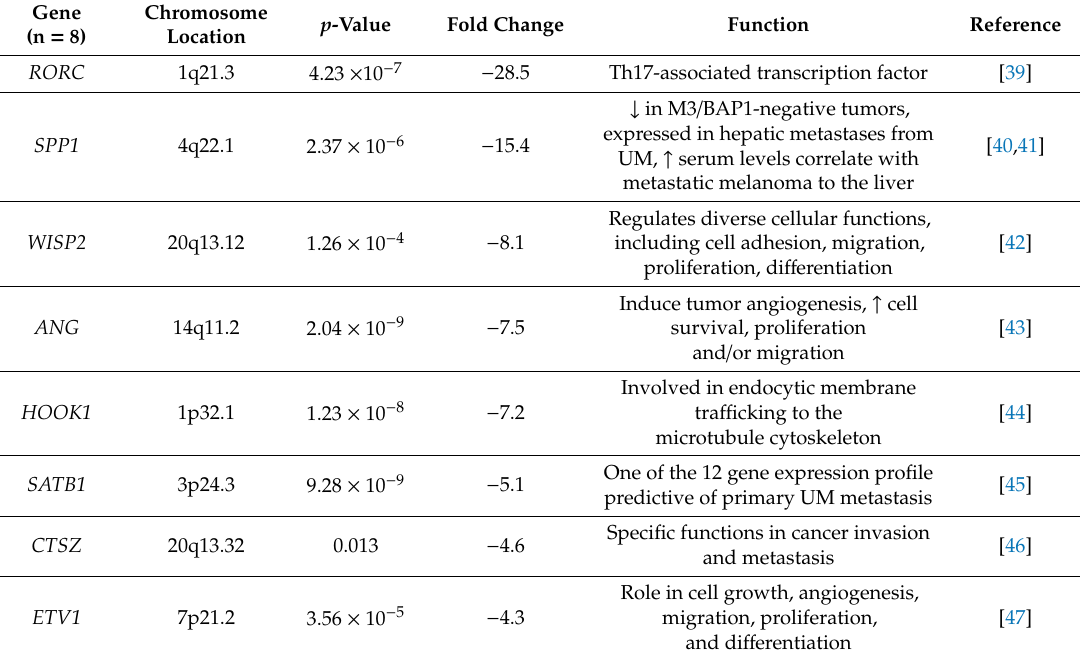
Table 4. A partial list of down-regulated EMT-associated genes in M3 tumors.